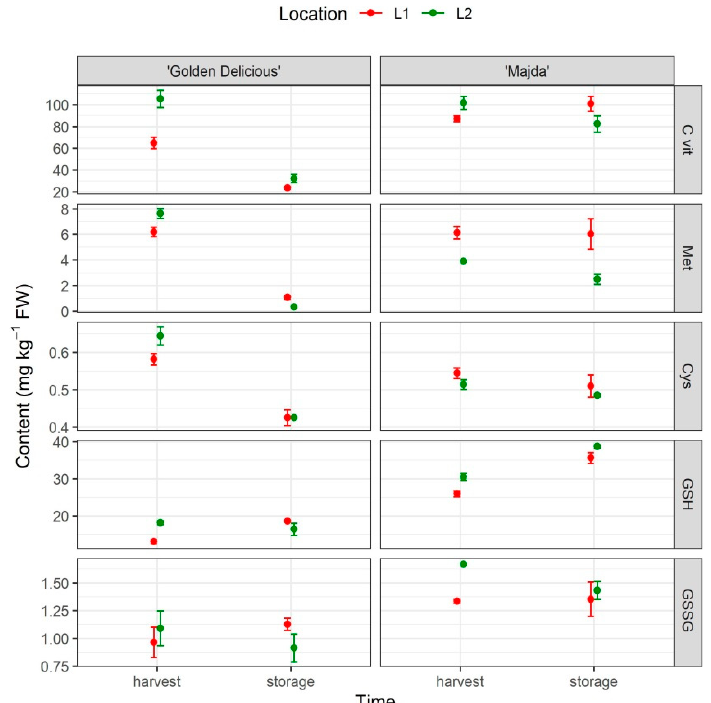
Figure 5. Vitamin C (C vit), methionine (Met), cysteine (Cys), reduced glutathione (GSH), and oxidised glutathione (GSSG) content in apple flesh (mg kg − 1 FW; mean ± SE) for cultivars ‘Golden Delicious’ and ‘Majda’ at two different locations (L1 and L2) at harvest and following